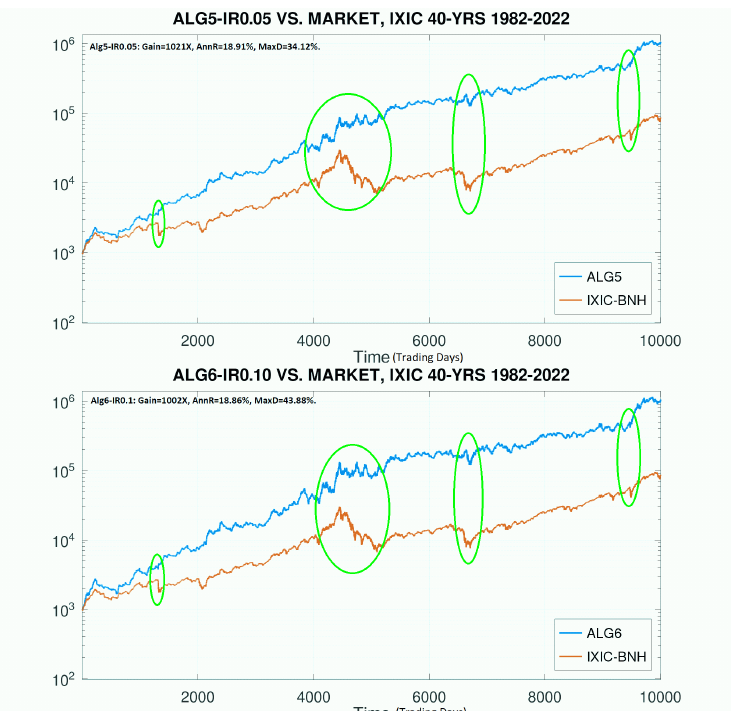
Figure 14. Results using some leveraging, with margin interest rates of 5%, and 10%, respectively. Even then, we are afforded strong performance, and reduced drawdowns, although clearly, there is a penalty due to the cost of